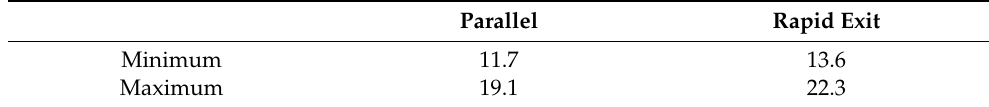
Table 13. Taxiway construction costs (Million $).